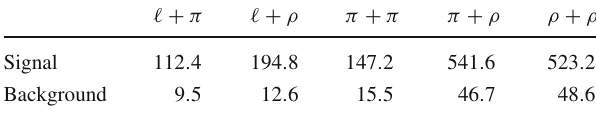
Table 3 The expected numbers of signal and background events with 5 ab − 1 of data in each channel after the cuts in Table 2 with Z → (cid:3)(cid:3), jj combined. Note that the (cid:3) + π/ρ and Z → jj channels are